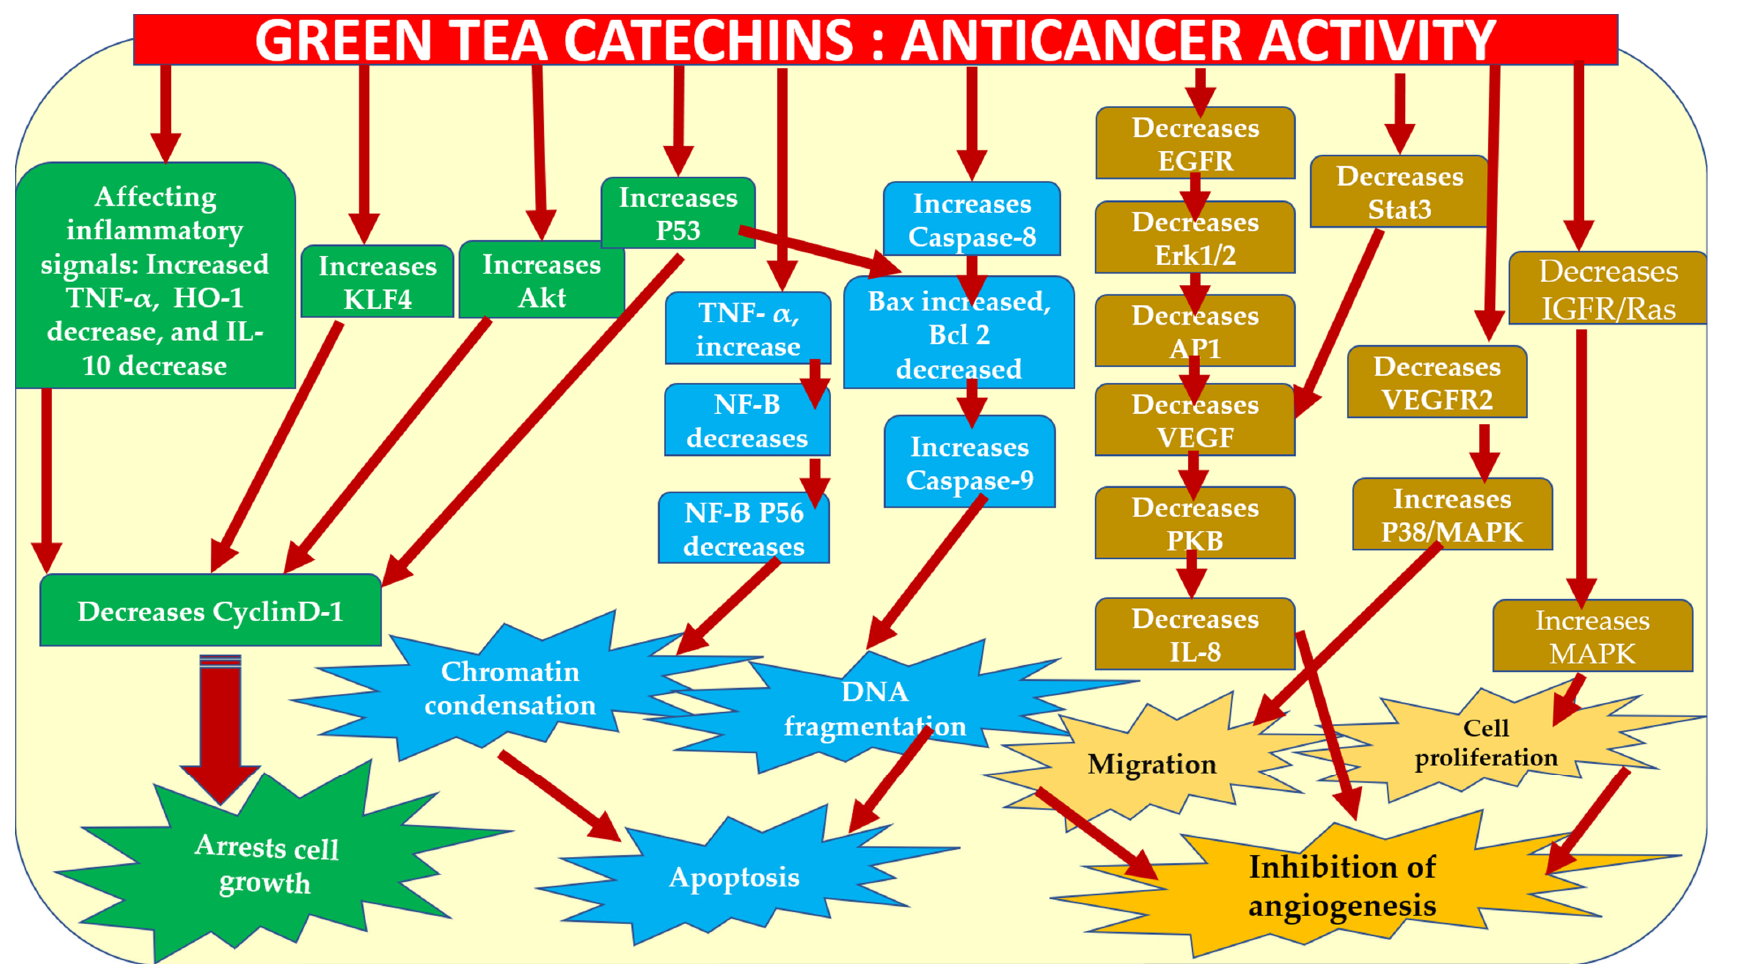
Figure 3. The molecular targets and signaling pathways behind the anticancer activity of GTCs. TNF—tumor necrosis factor; HO ‐ 1—Heme oxygenase ‐ 1; IL—interleukin; KLF4— Kruppel ‐ like factor 4.